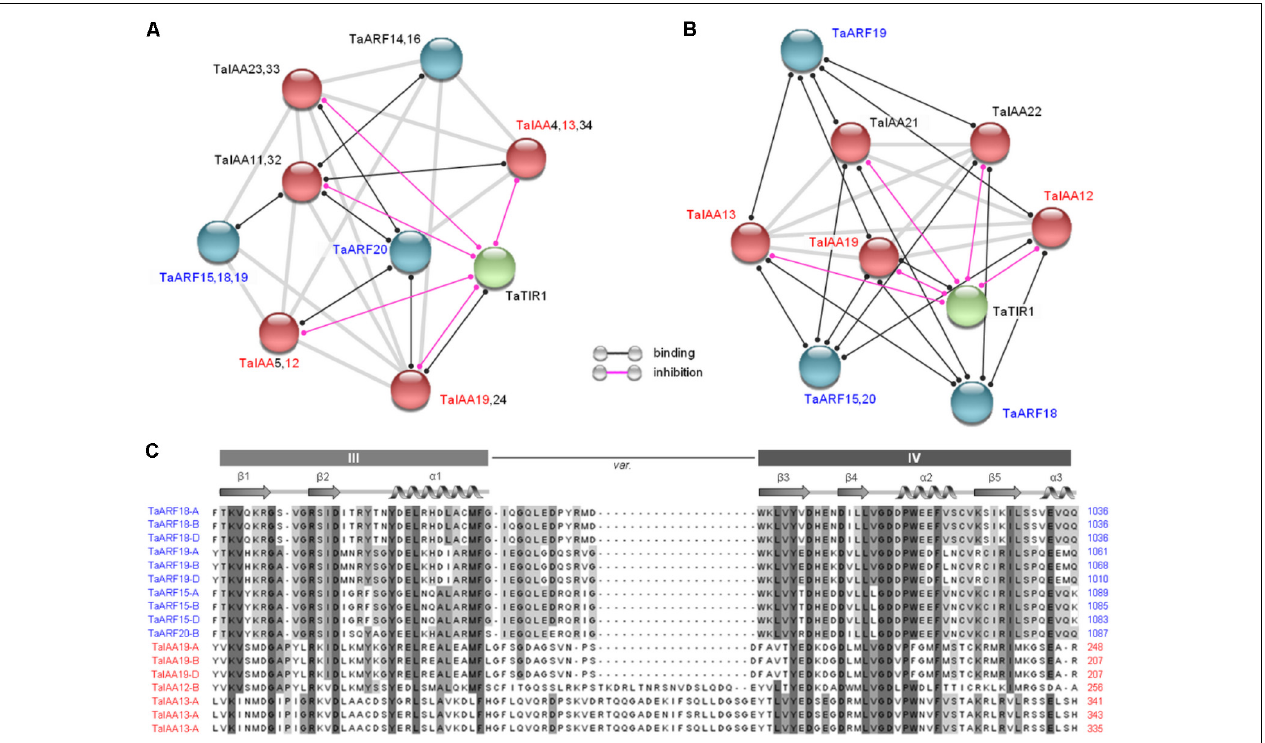
FIGURE 4 | Prediction of protein interactions among TaARFs, TaIAAs, and TaTIR1. (A,B) Interaction networks of 20 TaARF members, 25 TaIAA members, and TaTIR1 expressed in wheat based on the interaction models of Arabidopsis and rice. Proteins for which interactions were not detected are not shown. The line colors indicate the types of interactions, which are listed in the bottom. (C) Residues predicted to participate in ARF and IAA protein interactions. The sequence alignment of TaARF and TaIAA proteins revealed canonical CTD domain features, including the conserved domain III and domain IV. The variable linker region is indicated by var. The α structures are shown by a spiral, and the β structures are shown by